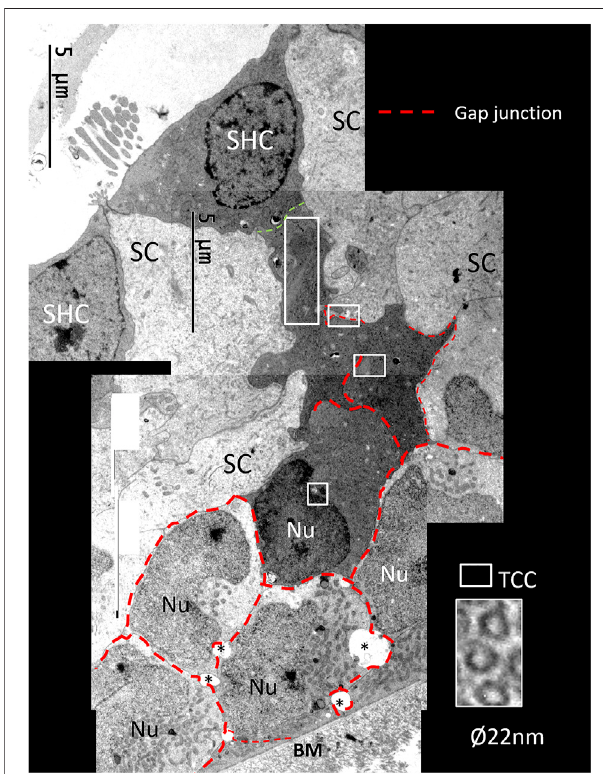
FIGURE 13 | Composite electron micrograph of SCs at the abneural zone of the basilar papilla at the lateral tip of the TM. An SHC is connected to several electron-dense SCs. These cells form a domain joined by GJs (red broken lines). Framed areas show regions with TCCs shown in higher magni fi cations in Figure 15